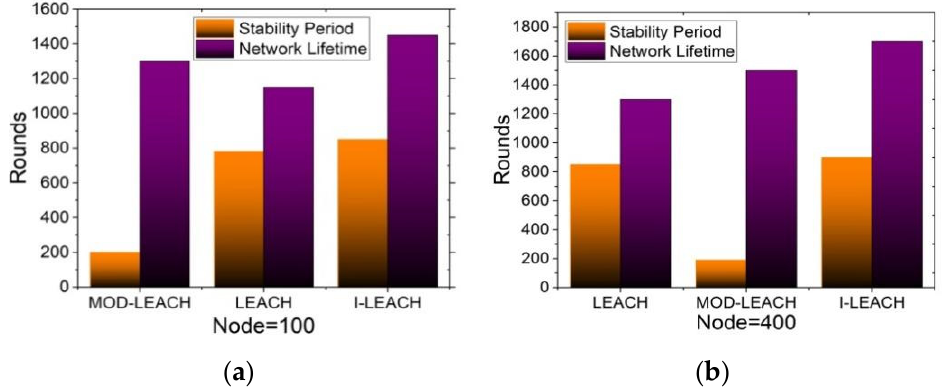
Figure 11. Lifetime metrics ( a ) n = 100 ( b ) n = 400. Deployment area = 100 × 100 m 2 . BS location (50, 50). Initial energy = 0.5 J.